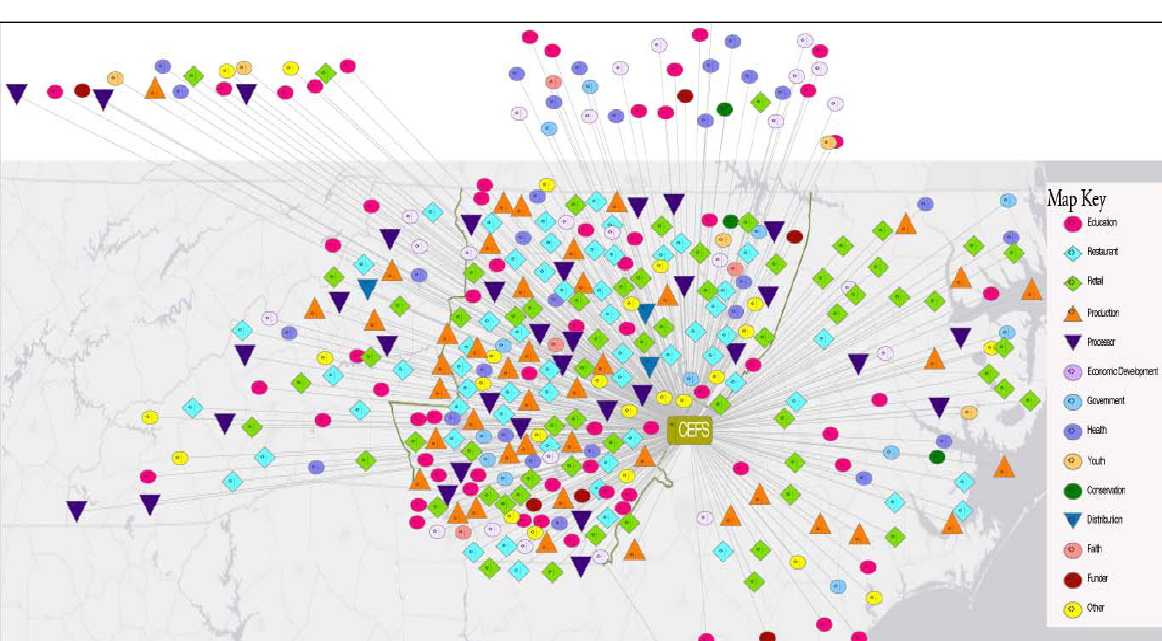
Figure 5. CEFS 2011 Network Map by Location and Type of